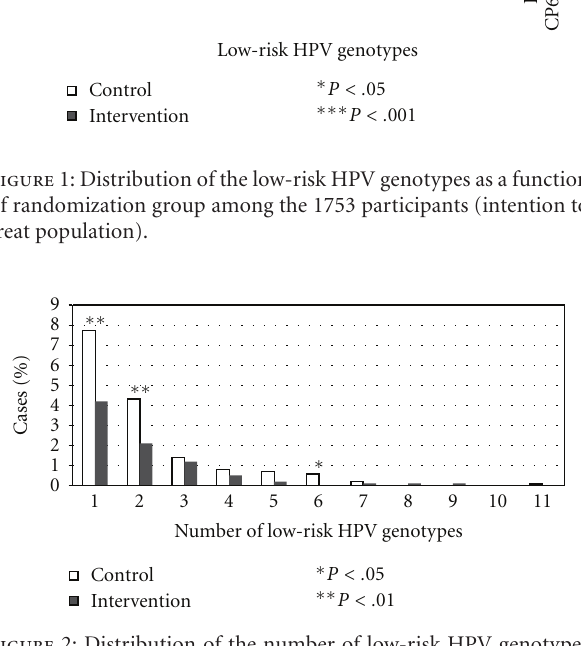
Figure 2: Distribution of the number of low-risk HPV genotypes collected in each urethral swabs as a function of randomization group among the 1753 participants (intention to treat popula-